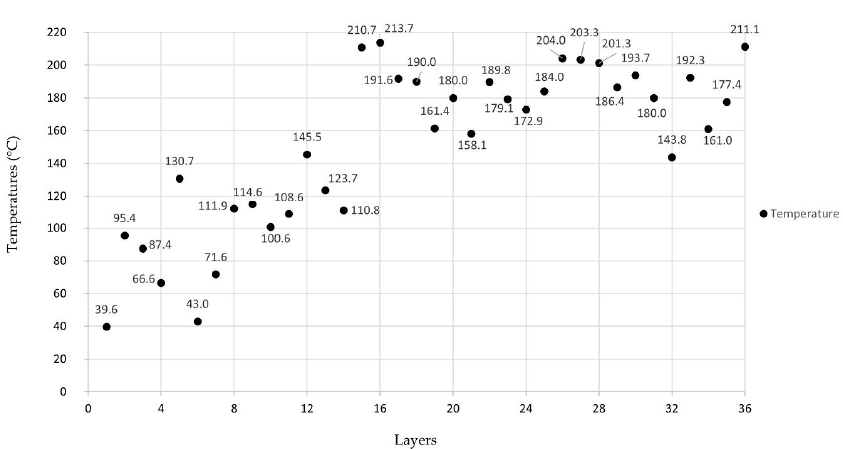
Figure 10. Temperature values of the deposition of the hot-wire PAW process per layer.